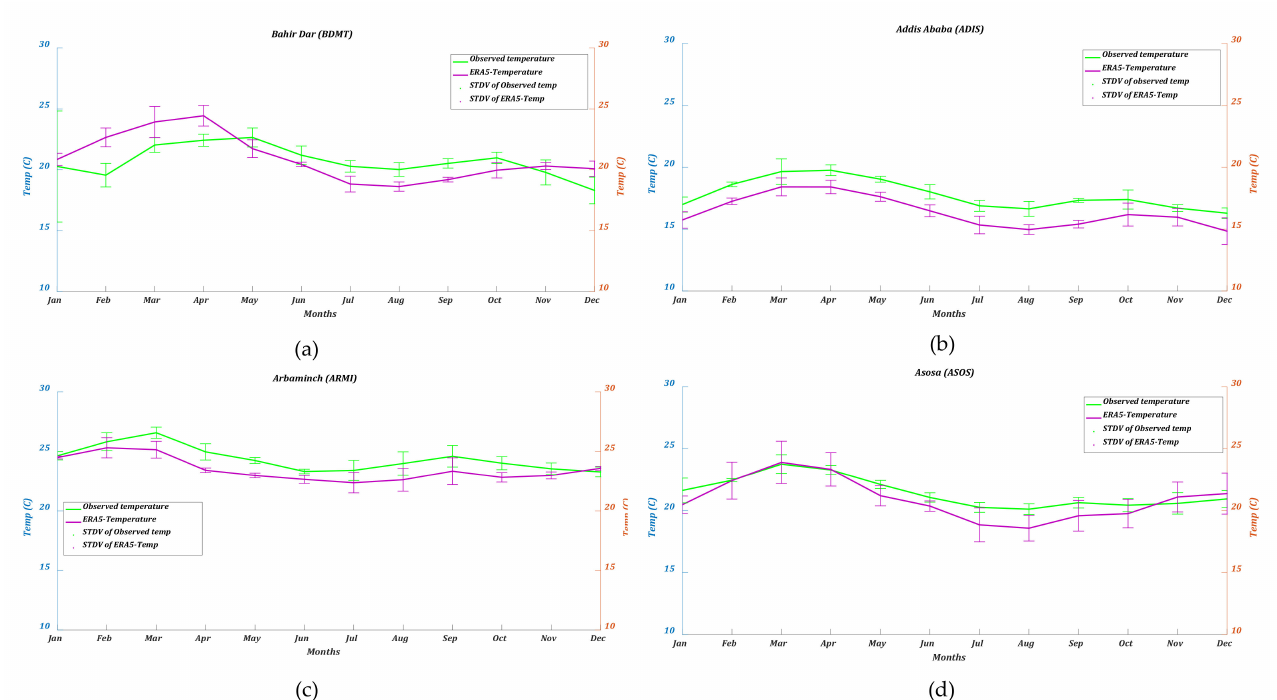
Figure 4. Seasonal variations of ERA5 and observed temperatures for the ( a ) BDMT, ( b ) ADIS, ( c ) ARMI, and ( d ) ASOS stations. The inter-annual variability is represented with vertical bars and denoted by